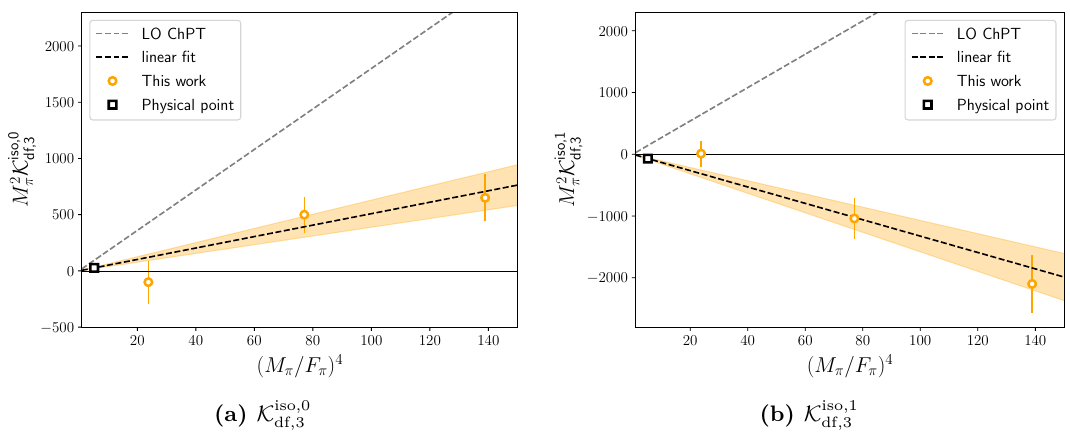
Figure 9. Results for the isotropic parameters in K df , 3 for pion scattering plotted against the expected leading chiral behavior, ( M π /F π ) 4 . Notation as in figure 5. We show the LO ChPT result for comparison.